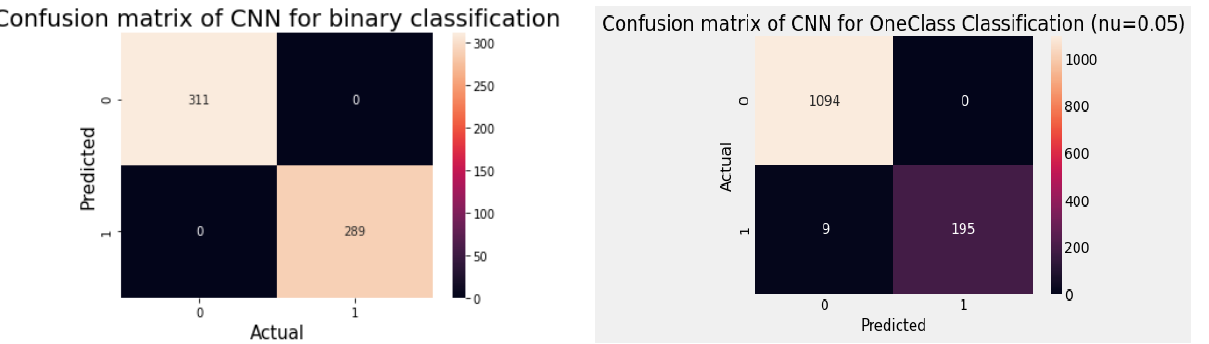
Figure 13. ROC curves for both tasks (left curve — binary classification, right curve — one-class classification).